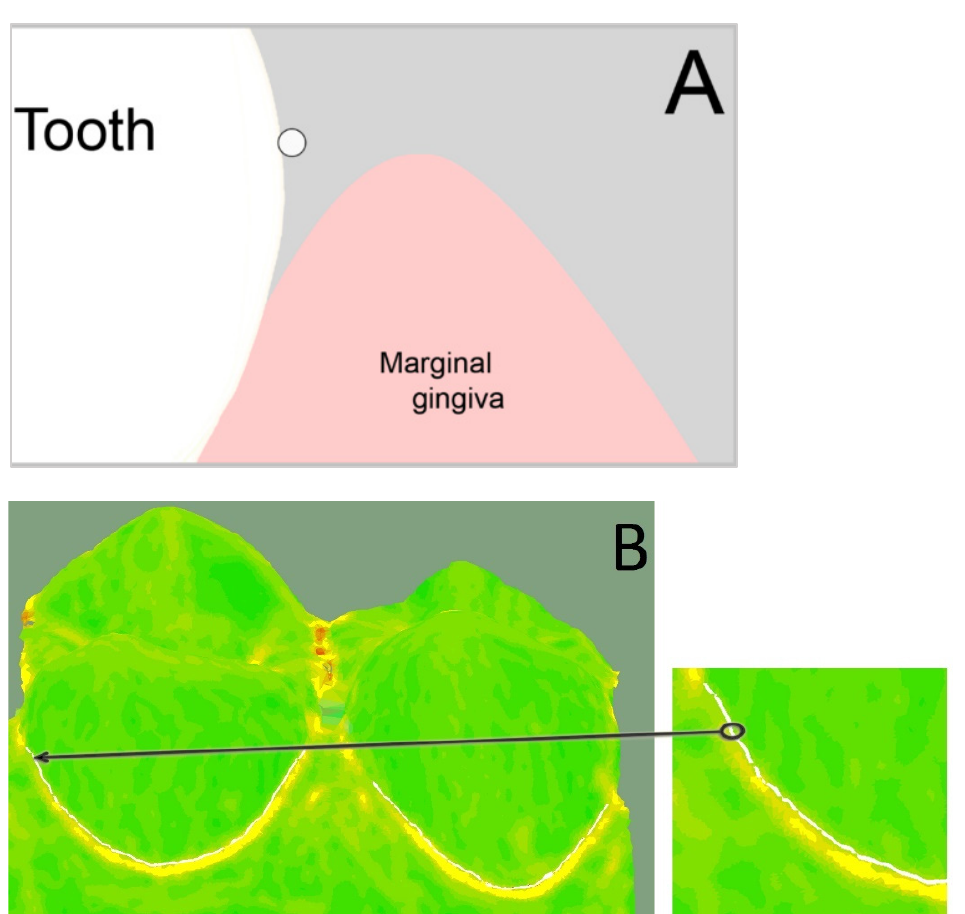
Figure 3. ( A ) Position of base curve (white dot) at the palatal dental cervix. Schematic view in cross section. ( B ) Creation of base curve (white line) at the transition from convex (color: green) to concave (color: yellow) on the palatal dental cervix of the premolars.